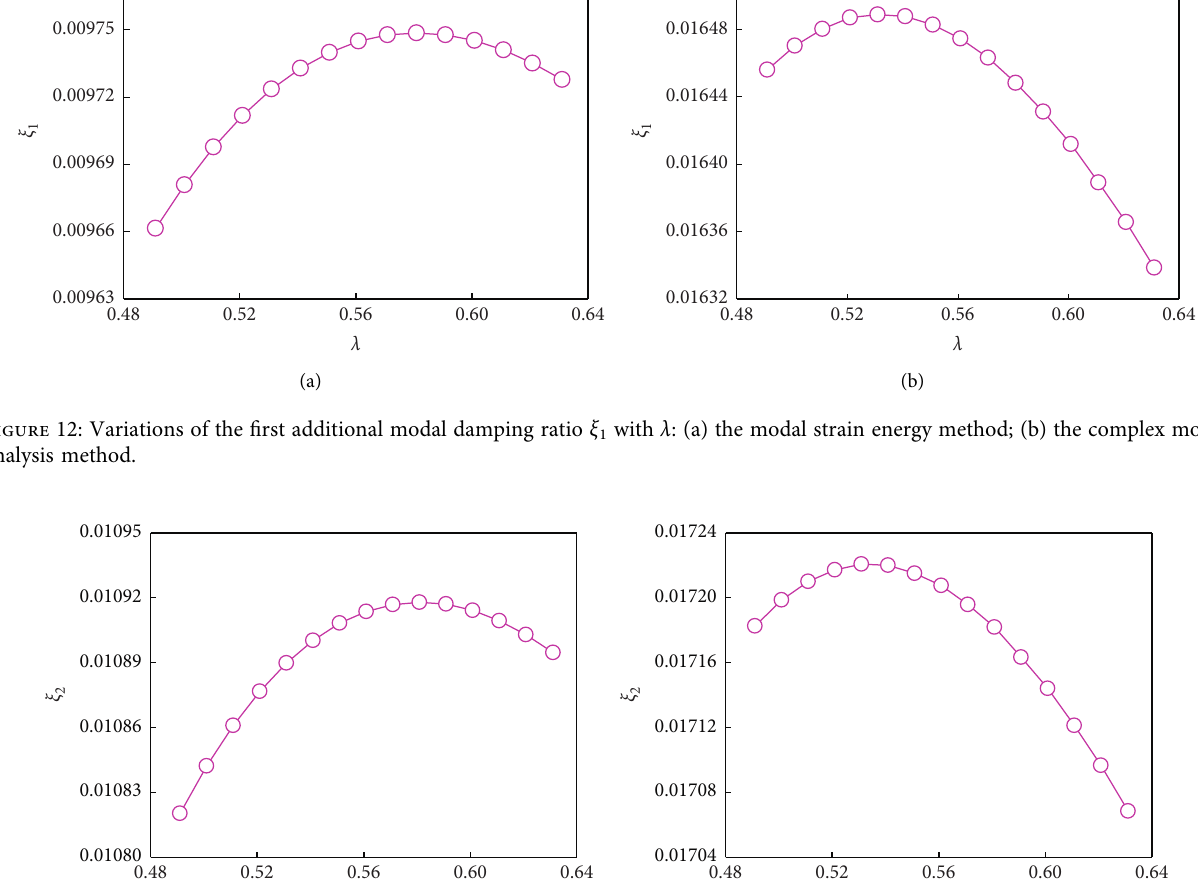
Figure 11: Variations of the first additional modal damping ratio ξ method; (b) the complex modal analysis method.